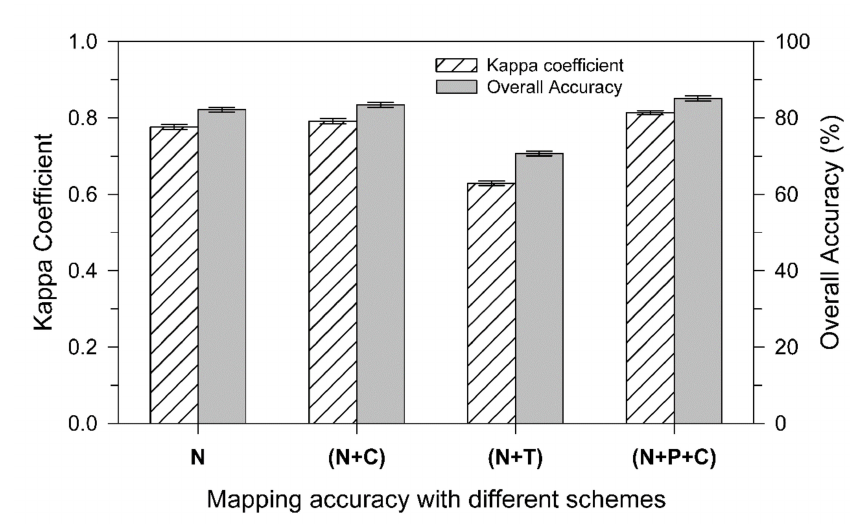
Figure 8. The kappa coe ffi cient and overall accuracy of tree species mapping using di ff erent schemes including 10-day NDVI time series images (N), four texture parameters (T), five phenological metrics (P) and contrast (C) of texture feature.